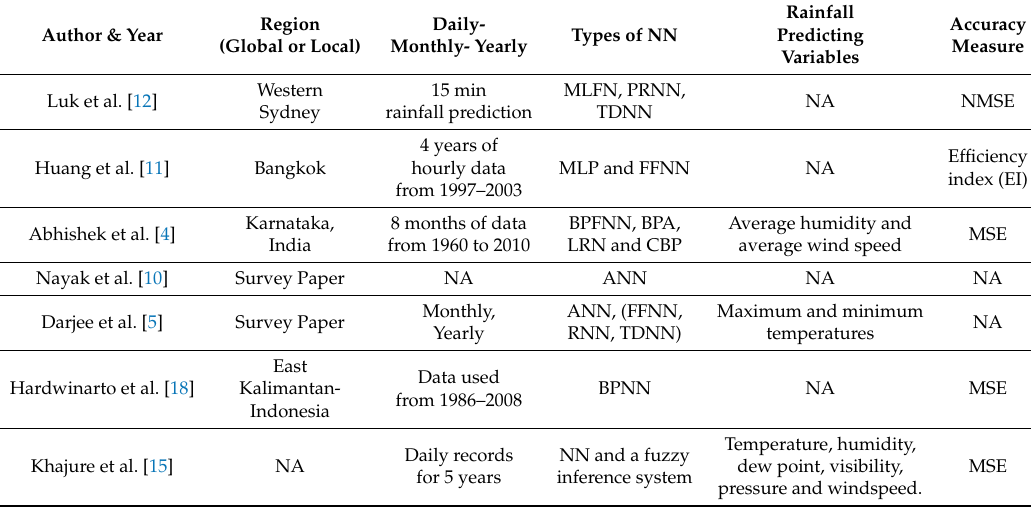
Table 1. Related work using Multi-Layer